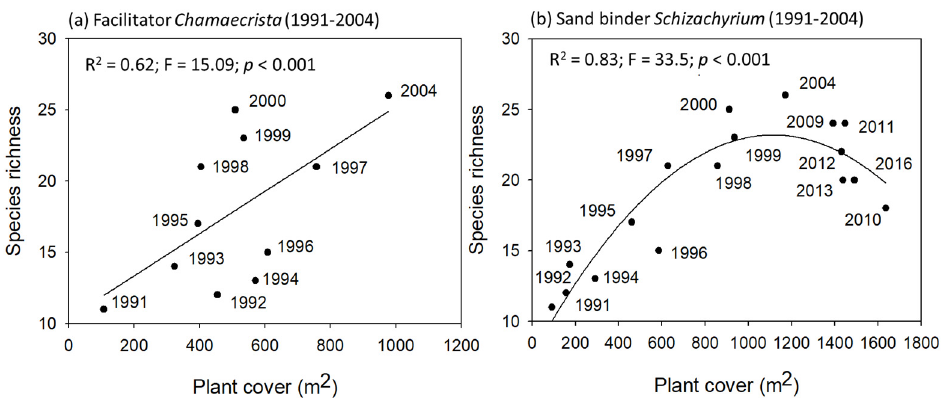
Figure 8. Correlation analyses between plant cover of the two most abundant species in the primary succession sequence and species richness. ( a ) Chamaecrista chamaecristoides is a facilitator from initial successional stages, and ( b ) Schizachyrium scoparius is a sand binder typical of intermediate stages. Black dots represent plant cover values of either the facilitator ( a ) or the sand binder ( b ), respectively, and the total species richness observed each year.